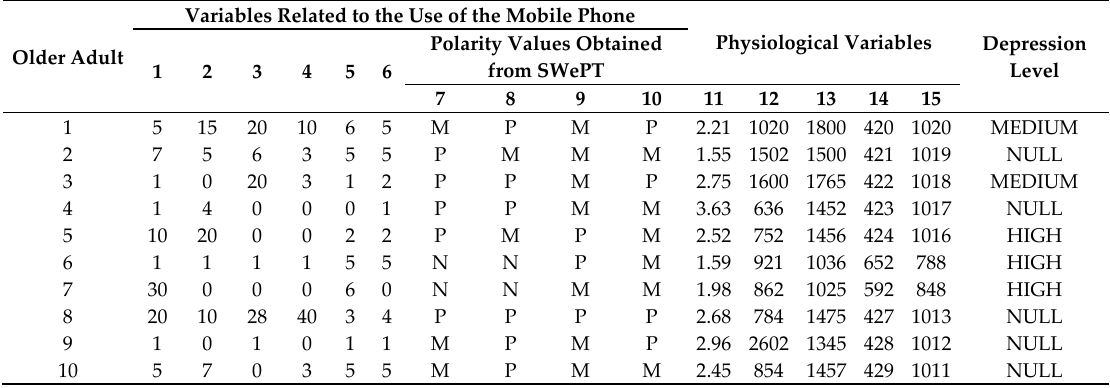
Table 1. View with the variables and a sample of the